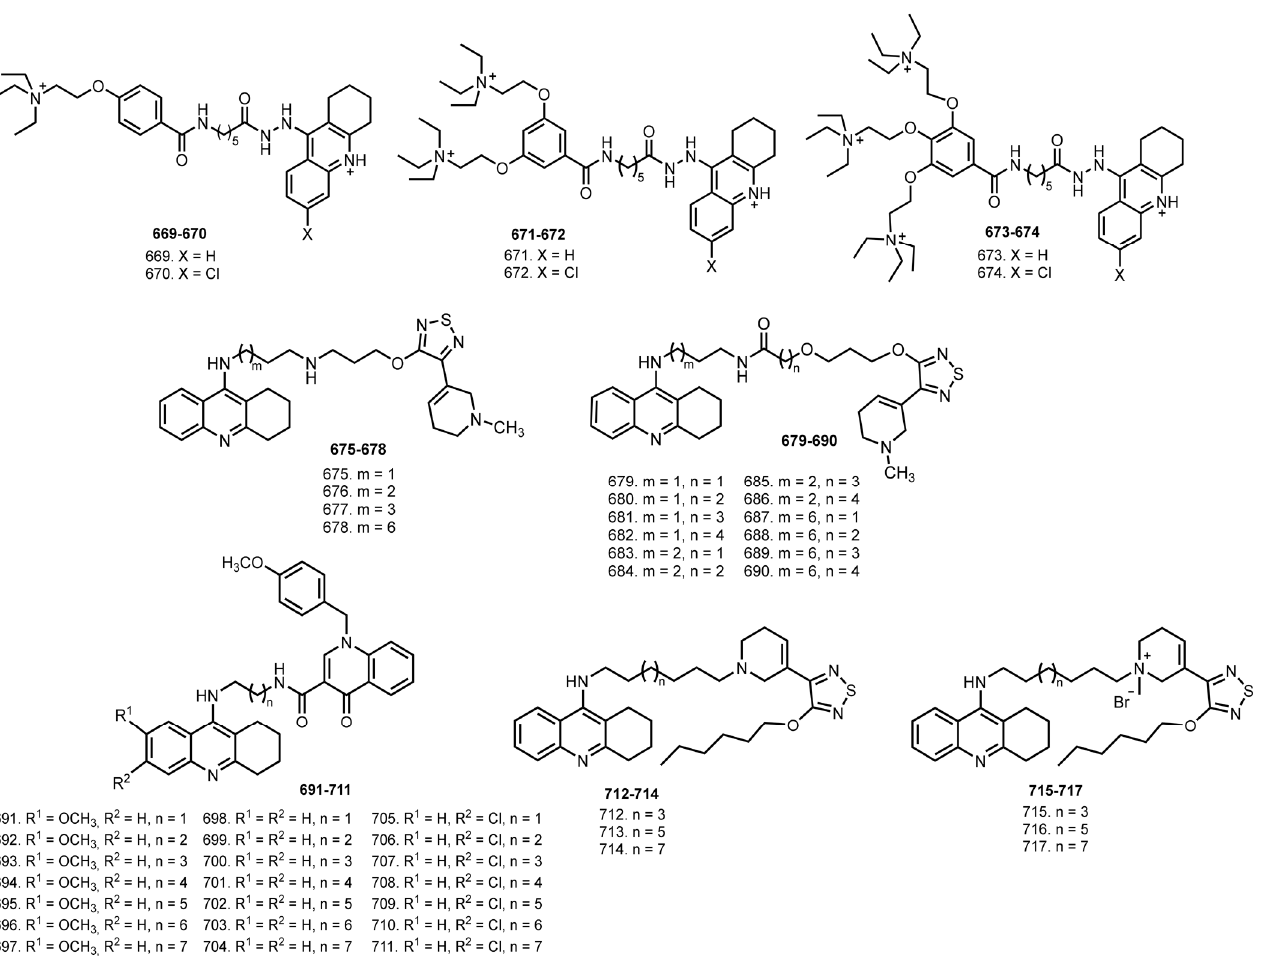
Figure 27. Gallamine–THA hybrids 669 – 674 [103], THA–xanomeline hybrids with amine linker 675 – 678 and amide linker 679 – 690 [104], 7 ‐ MEOTA–BQCA hybrids 691 – 697 , THA–BQCA hybrids 698 – 704 , 6 ‐ Cl ‐ THA–BQCA hybrids 705 – 711 [105], and THA–xanomeline hybrids 712 – 717 [106].